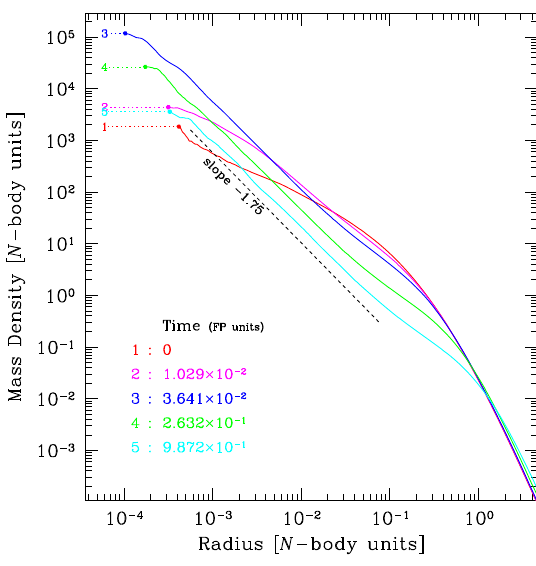
Fig. 21 Density profile for a galactic nucleus with a single stellar population in different moments of the evolution of the system, in Fokker–Plank units (FP), as defined in the footnote. Image reproduced with permission from Freitag et al. (2006b), copyright by